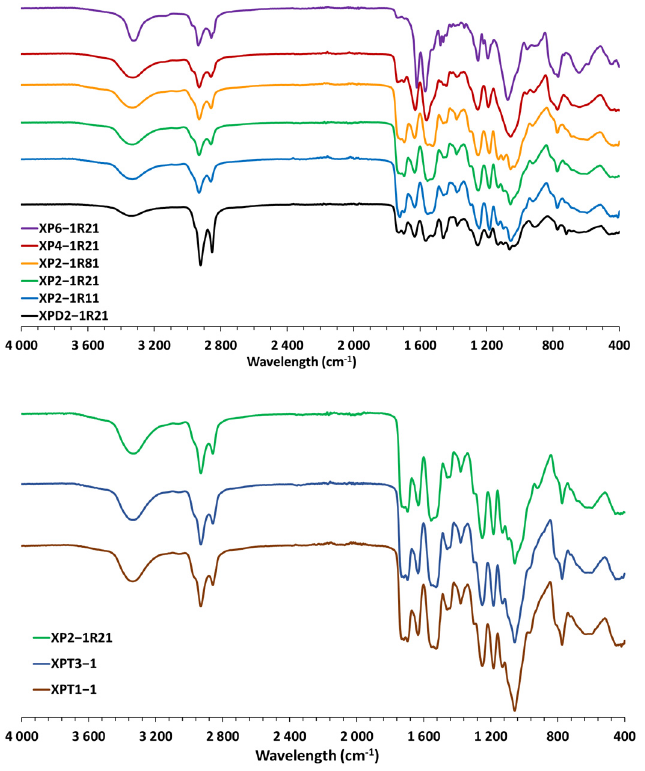
Figure 3. Xerogels FTIR-ATR spectra.